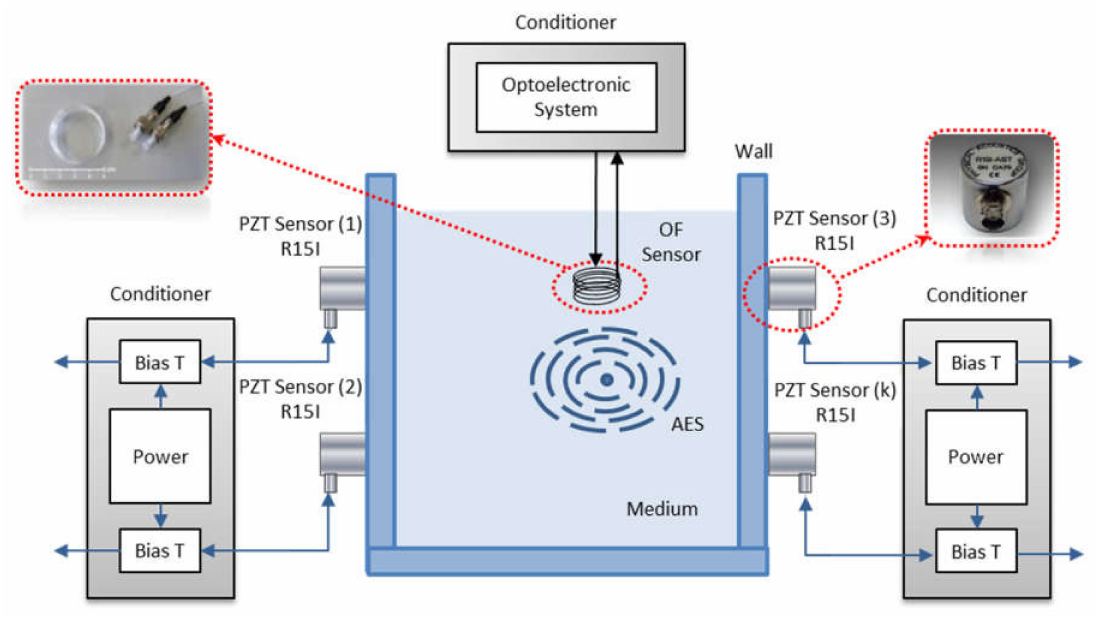
Figure 1. The instrumentation system based on OF and PZT sensing.